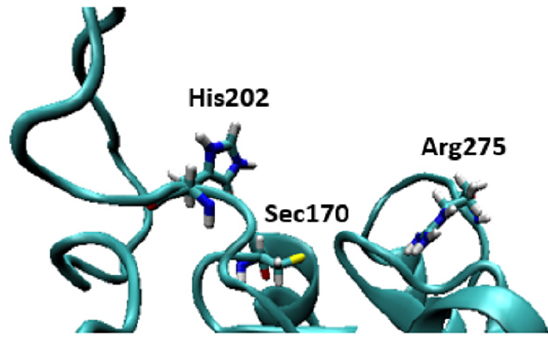
Figure 7. Density functional theory (DFT) optimized structures of XB complexes at the ortho and para positions of hydroxylated BDE-47 metabolites. Distances are in Angstroms.